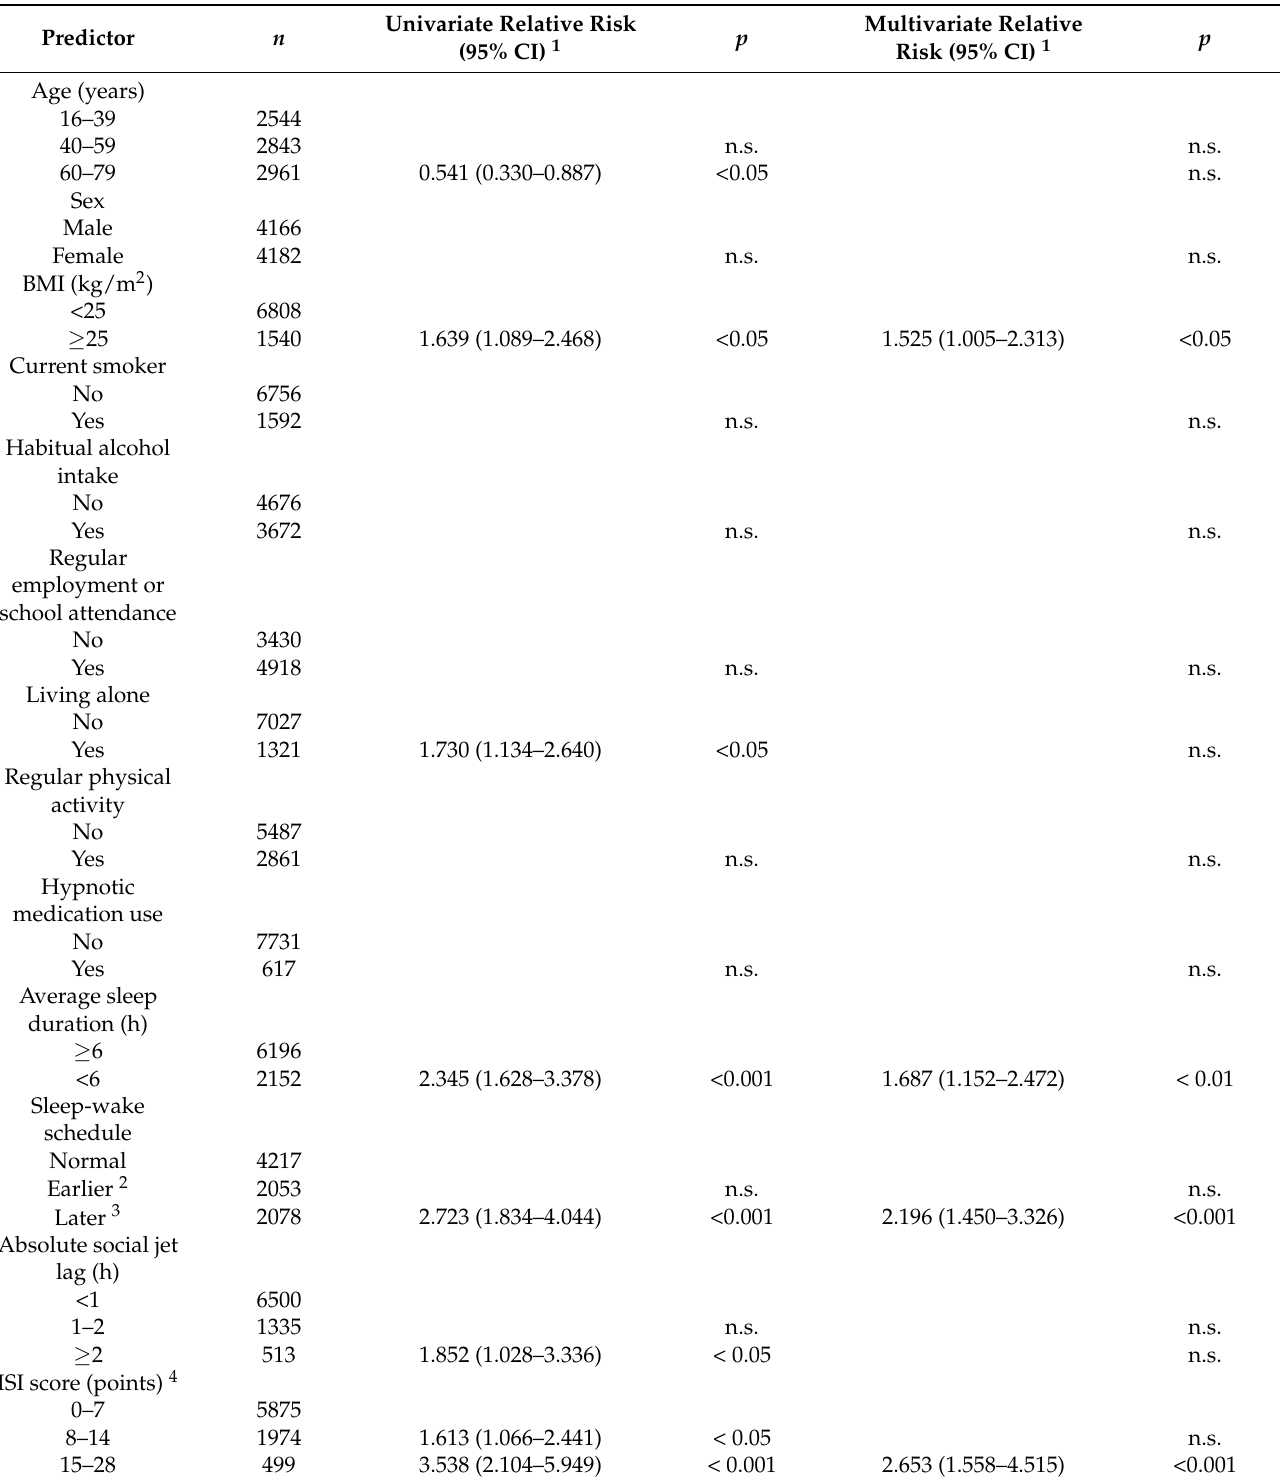
Table 2. Factors associated with evening hyperphagia ( n =